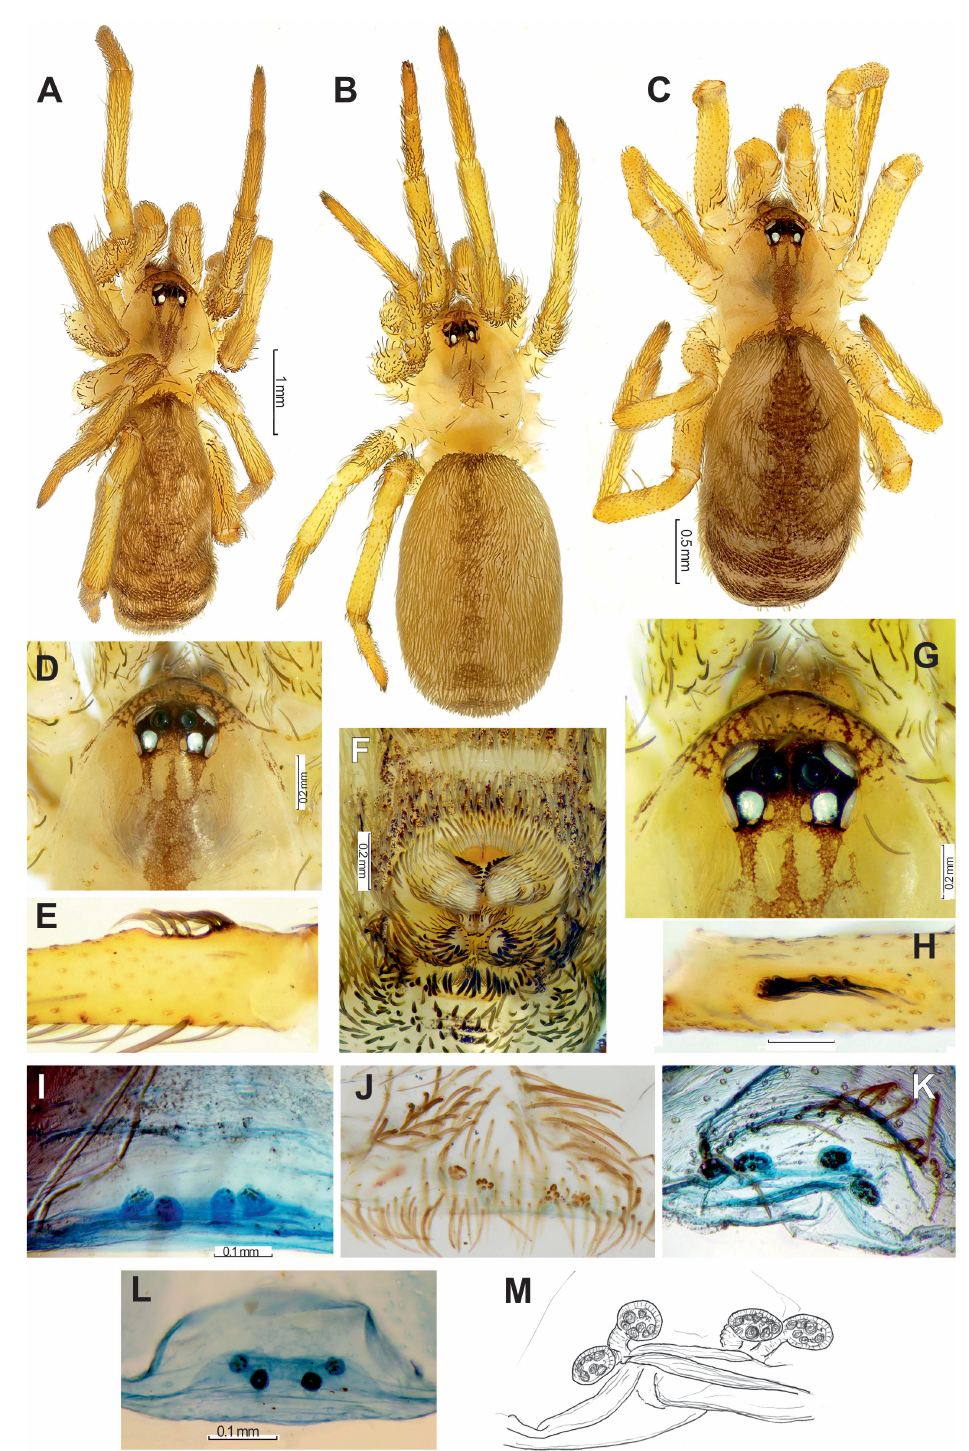
Fig. 41. Somatic characters and endogyne of Zaitunia zonsteini Fomichev & Marusik, 2012 ( A–H , J–K , M ), and ♀♀ from Taldykorgon ( I , L ). — A – C . Habitus, dorsal, showing variations of pattern. D , G . Cephalic part of prosoma, dorsal. E , H . Calamistrum, lateral and dorsal. F . Posterior part of abdomen, ventral. I–J . endogyne, dorsal. K , M . Same, anterior. L . Same, subcaudal (receptacles visible from below). Scale bars: A = 1.0 mm; B–C = 0.5 mm; D, F–H = 0.2 mm; I, L = 0.1